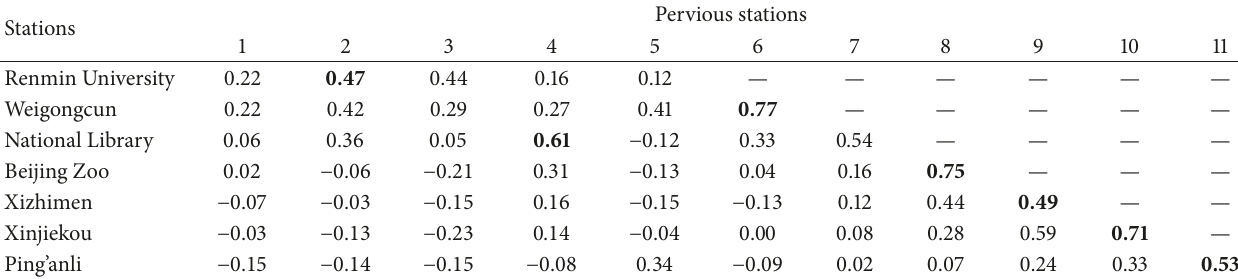
Table 10: Correlation coefficients of the dwell time in peak periods.